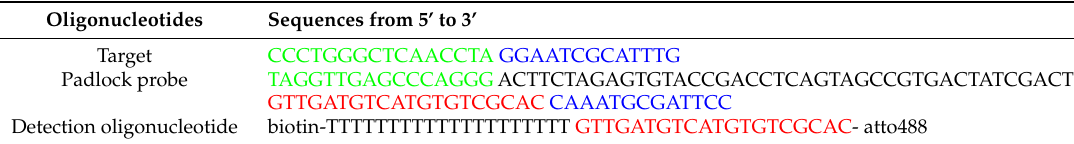
Table 2. DNA sequences of target, padlock probe and detection oligonucleotide for rolling circle amplification of Vibrio Cholerae. The padlock probe has motifs that matches the target Cholera sequence (green and blue) and forms a circle by hybridizing to it. The detection oligonucleotide is part of the padlock probe (red) and therefore, hybridizes with the RCP of the circularized padlock probe.